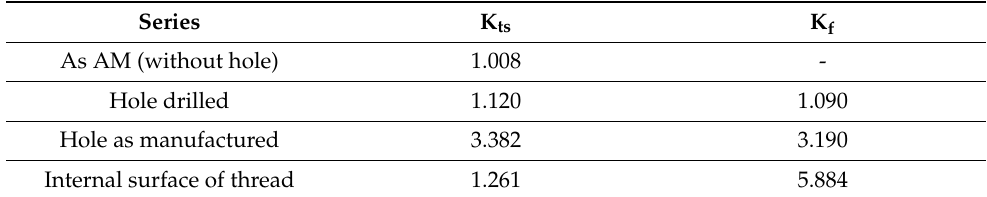
Table 3. Stress concentration